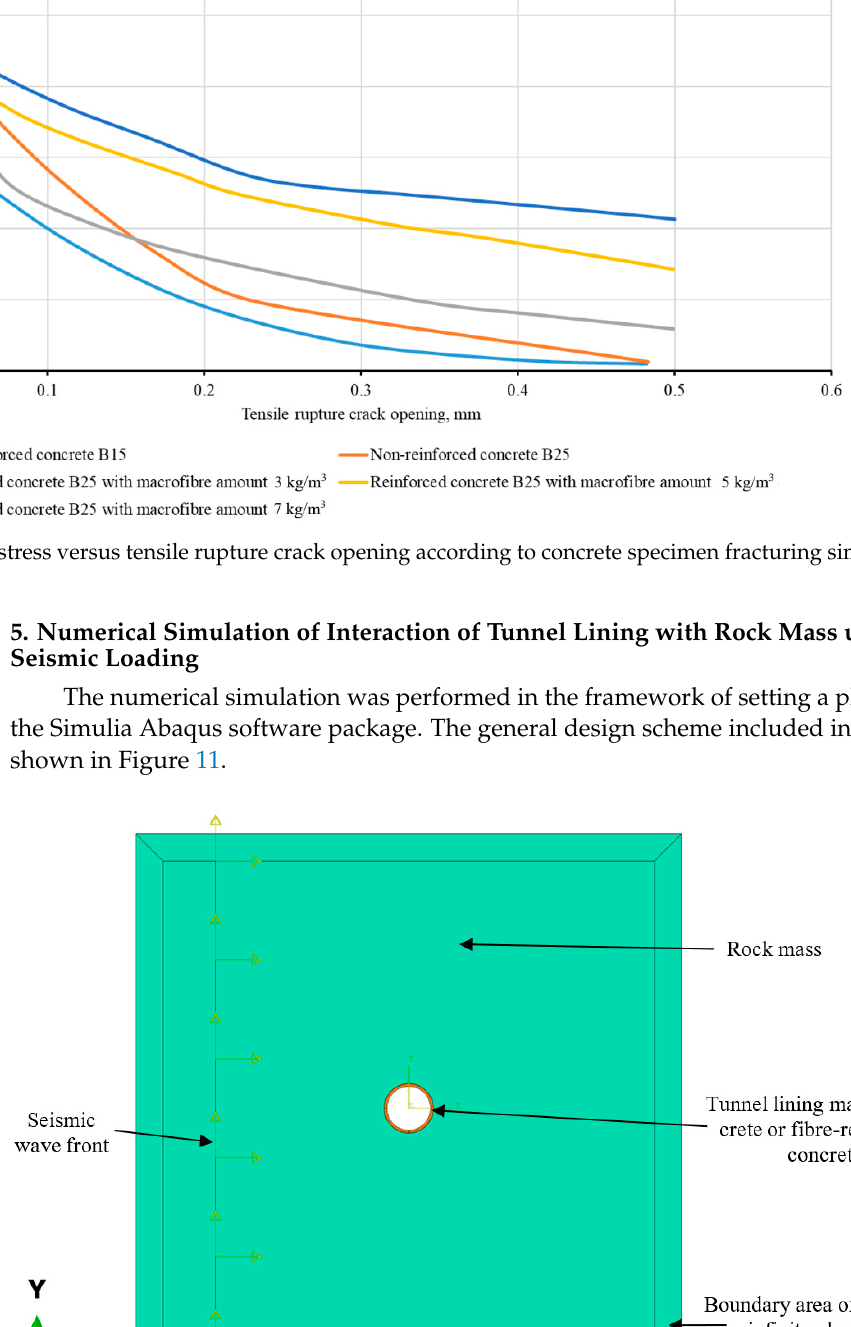
Figure 9. Deformation of a concrete specimen under uniaxial tension based on numerical modeling.